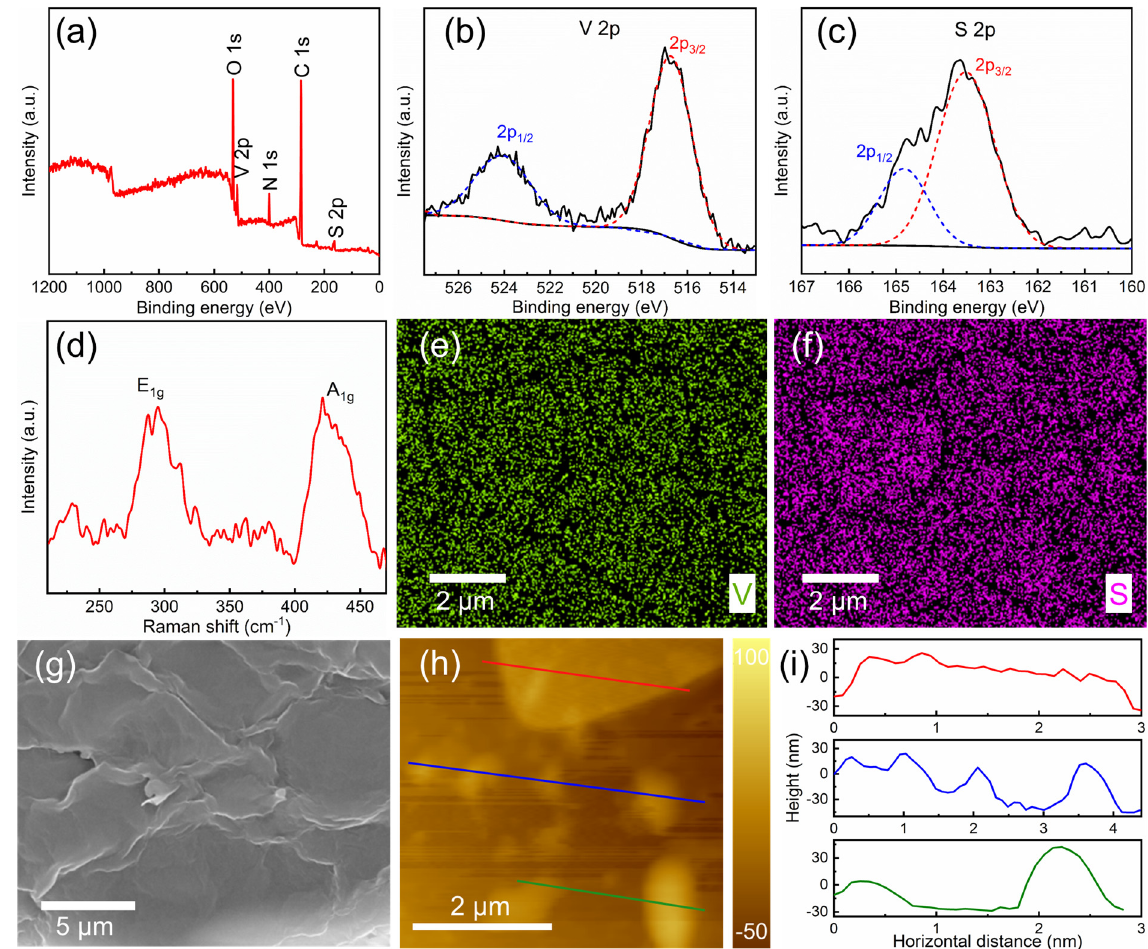
Figure 1. ( a ) XPS survey spectrum and core high-resolution spectra of ( b ) V 2p; ( c ) S 2p for the VS 2 nanosheets; ( d ) Raman spectra of VS 2 nanosheets; ( e,f ) EDS images showing morphology and element distribution; ( g ) SEM image of VS 2 samples; ( h ) AFM image; and ( i ) the corresponding height profile of VS 2 SA.